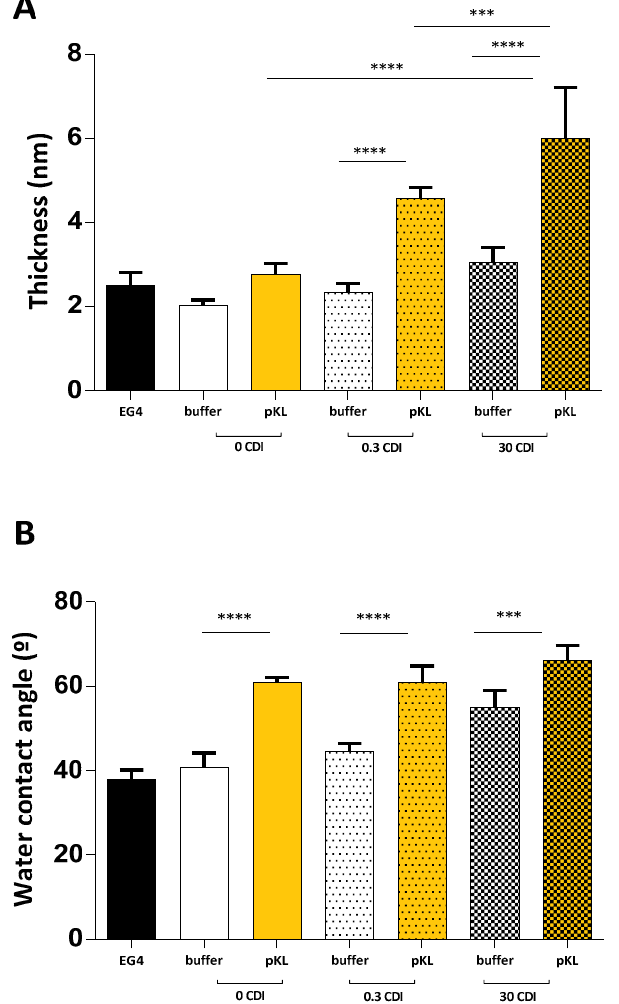
Figure 1. ( A ) Ellipsometry of pKL-SAMs and buffer-SAMs with increasing CDI concentrations. Data are expressed as average ± STDEV of three replicates per condition. Statistically significant differences: *** p < 0.001; **** p < 0.0001. ( B ) Water contact angle of pKL-SAMs and